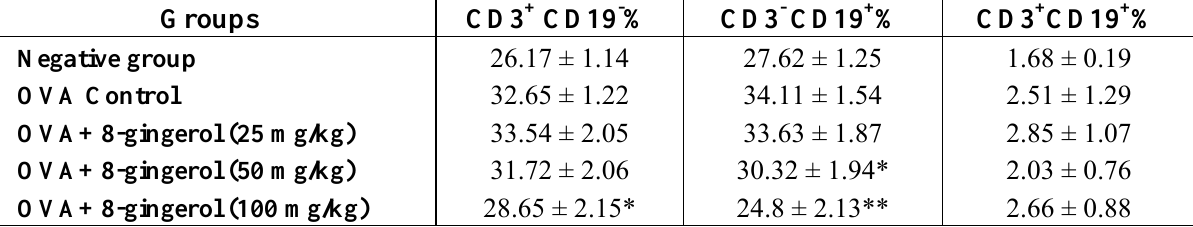
Table 1. Effect of 8-gingerol on CD3+ and CD19+ lymphocytes Subsets in OVA- immunized